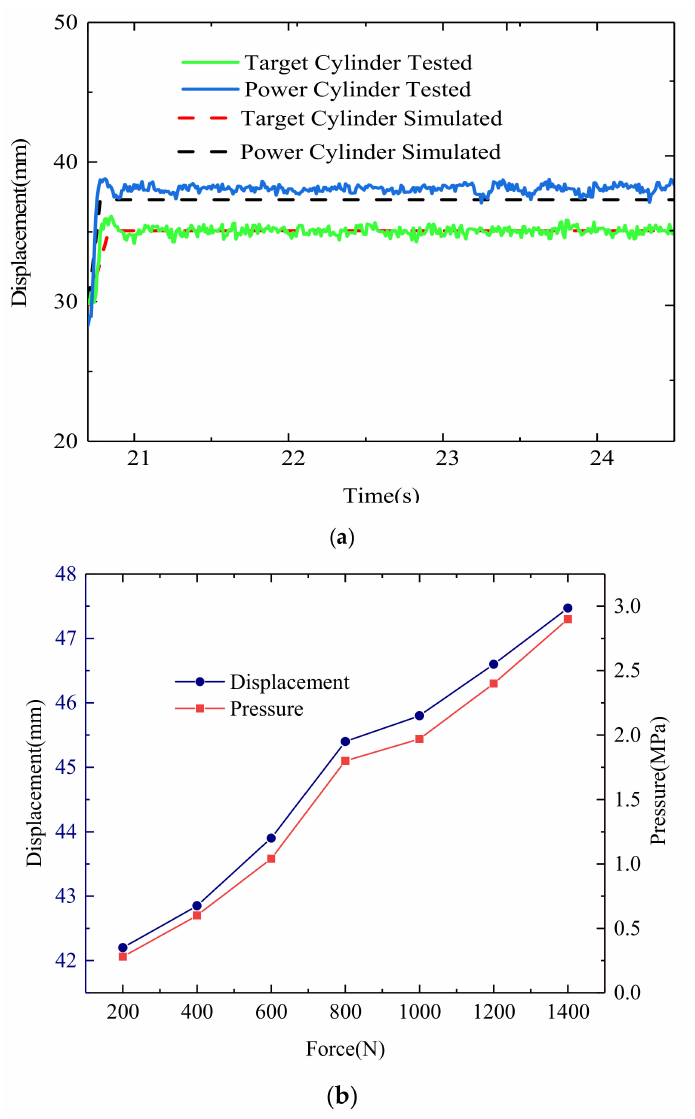
Figure 7. ( a ). Displacement of two cylinders. ( b ). Displacement of the target cylinder and pressure in the rodless